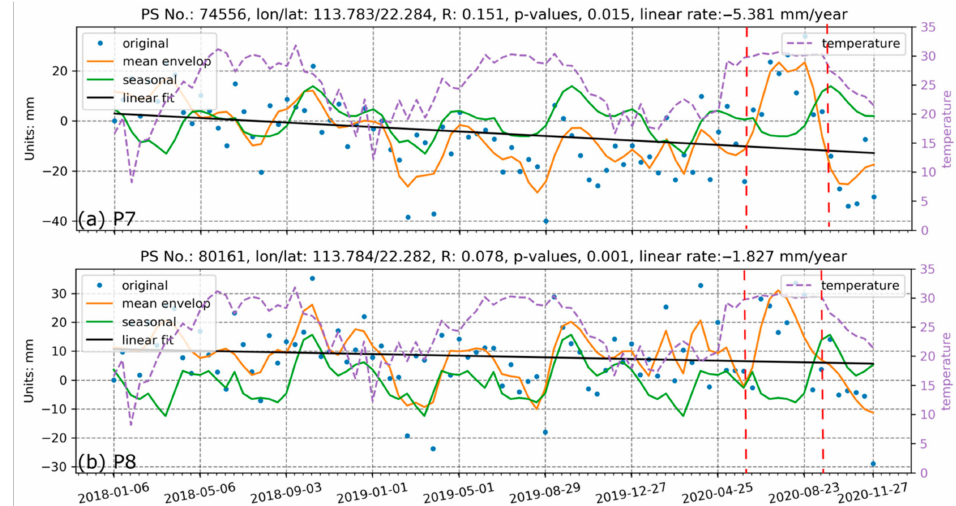
Figure 12. Time-series processing results of ( a ) P7 and ( b ) P8 at the north and south of the west man-made island. The red dashed lines indicate sudden uplifts on P7 and P8 between the middle of June and the middle of September in 2020.